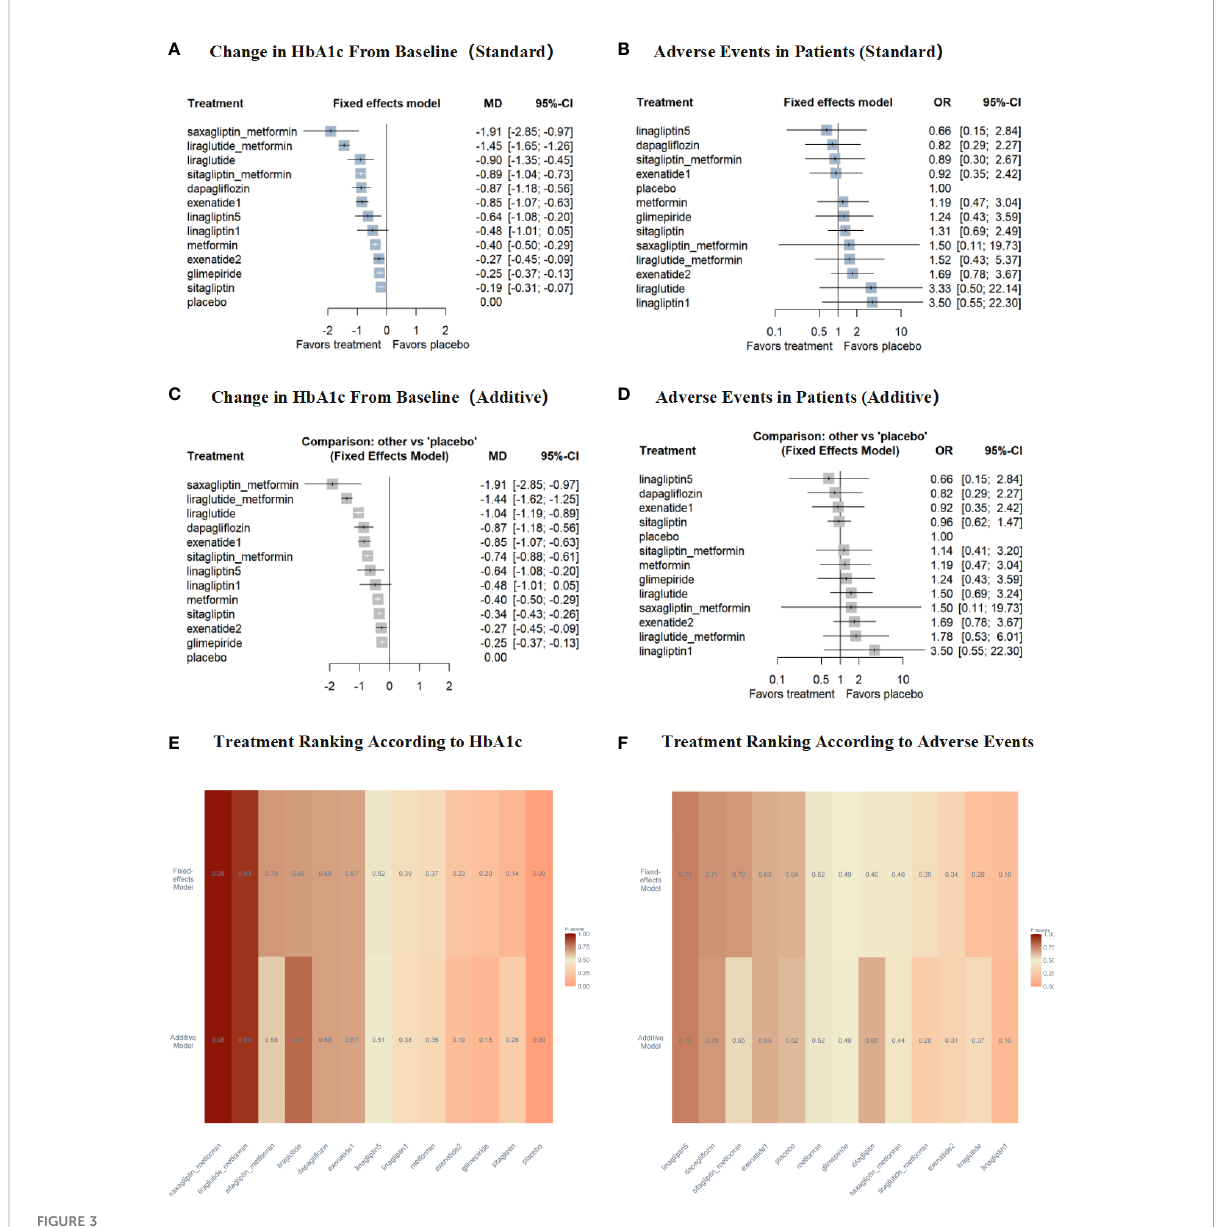
FIGURE 3 Results for the primary outcomes compared with placebo. Treatments are presented according to their effect estimate compared with placebo. Effect sizes are presented as MD or OR with 95% CI's. MD, mean difference; OR, odds ratio. exenatide1, exenatide-2mcg; exenatide2, exenatide-5/10mcg; linagliptin1, linagliptin-1mg; linagliptin5, linagliptin-5mg. (A) the change in HbA1c from baseline of fi xed effects model; (B) adverse events of patients of fi xed effects model; (C) the change in HbA1c from baseline of additive model; (D) adverse events of patients of additive model; (E) treatment ranking according to HbA1c of both models; (F) treatment ranking according to adverse events of both